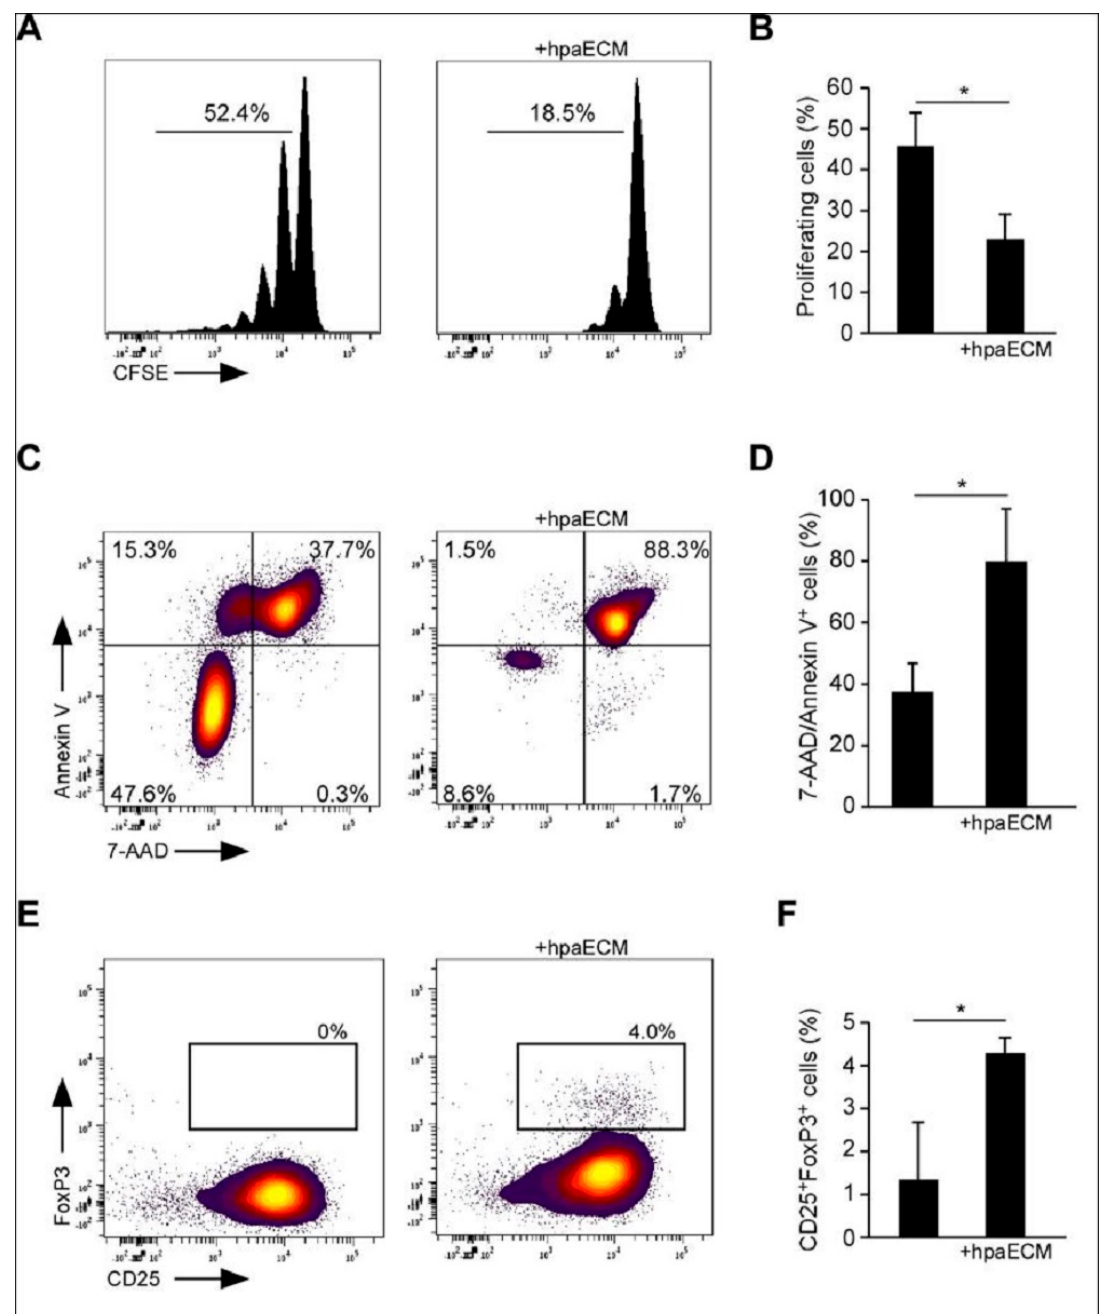
Figure A2. Immune properties of ECM scaffolds obtained from the human pancreas. ( A ) Representative plots and ( B ) quantitation of carboxyfluorescein succinimidyl ester (CFSE) dilution in CFSE-labeled human naïve CD4 + T cells stimulated with anti-CD3/anti-CD28-coated beads cultured with or without pulverized ECM; ( C ) Representative plots and ( D ) quantitation of Annexin-V and 7-AAD expression as a measure of apoptosis/necrosis in human naïve CD4 + T cells stimulated with anti-CD3/anti-CD28-coated beads cultured with or without ECM; ( E ) Representative plots and ( F ) quantitation of FoxP3 expression in CD4 + CD25 + cells converted from human naïve CD4 + T cells stimulated with anti-CD3/anti-CD28-coated beads and IL2 cultured with or without ECM (with permission from Peloso et al. Ann Surg 2015, ahead of print) [145]. * denotes p < 0.05.